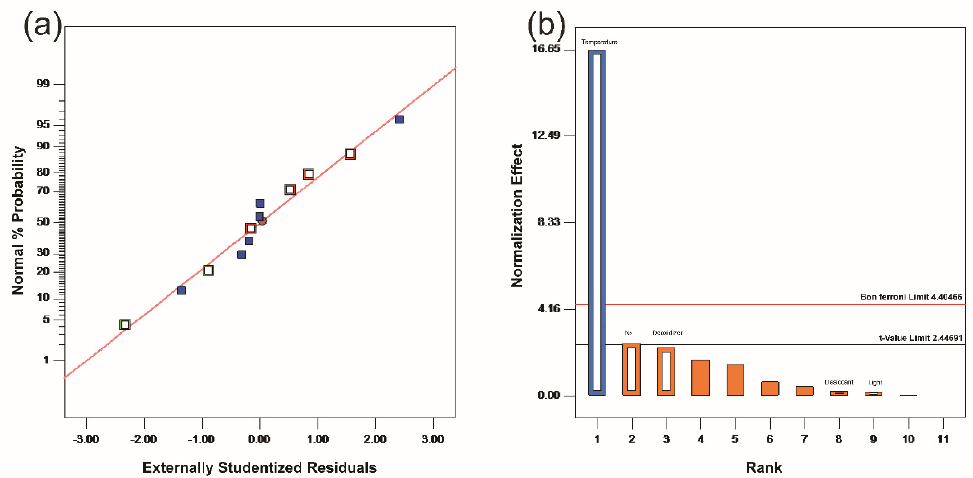
Figure 2. PB experiment of Cap-NO · H 2 O: ( a ) normal plot of residuals; ( b ) Pareto chart (Alpha = 0.05).